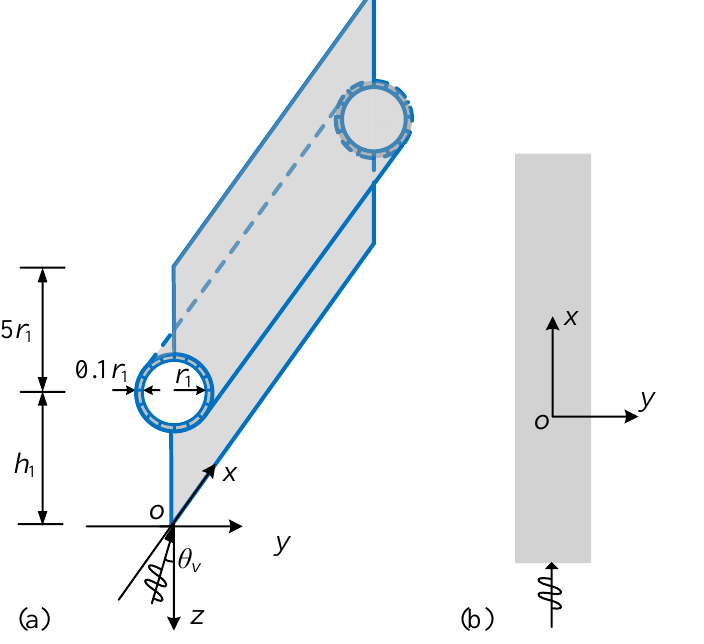
Table 2. The dimensionless parameter is η = ω r 1 / π c s = 0.105.